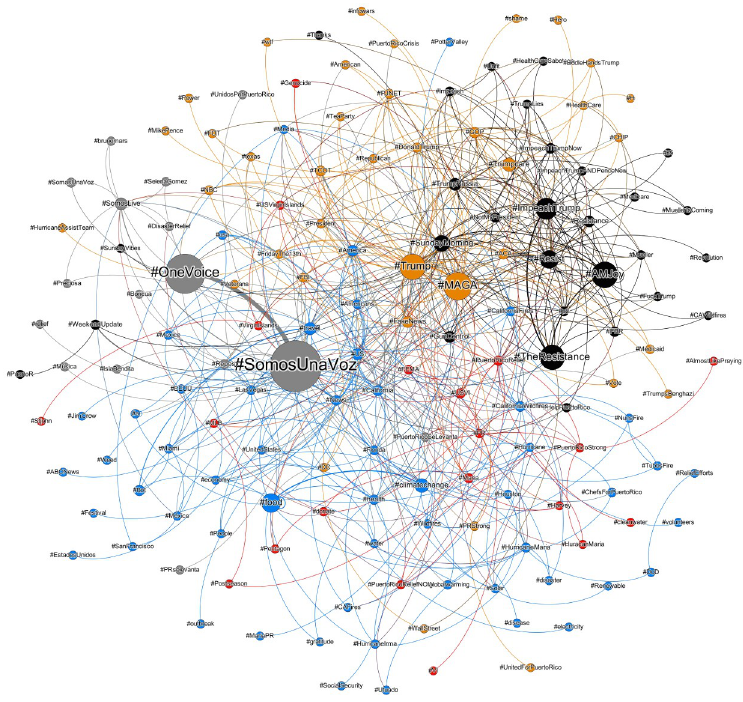
Fig 6. The superposition of daily hashtag ego networks for #PuertoRico. Nodes are sized proportionally to the degree of each node, and edges are resized proportionally to their weight, a representation of the number of co- occurrences of the hashtags at either end of the